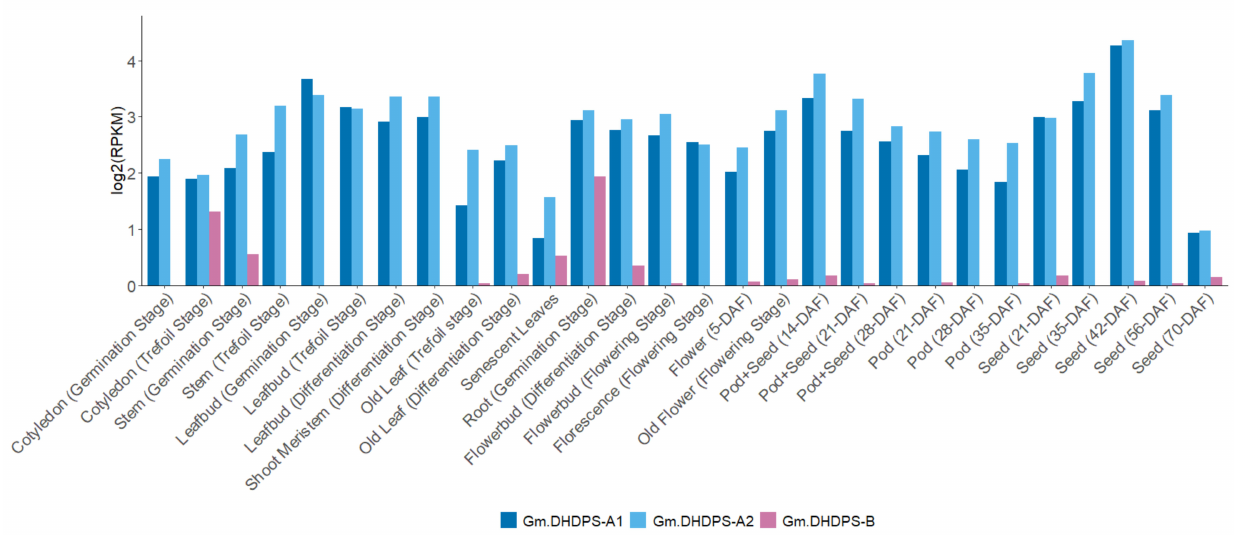
Figure 5. Bar chart representation of the DHDPS RPKM values ( Y -axis) in 28 samples ( X -axis) in G. max by RNA-seq re-analysis of data originating from [32]. All RPKM values are log2-transformed; (DAF = Days After